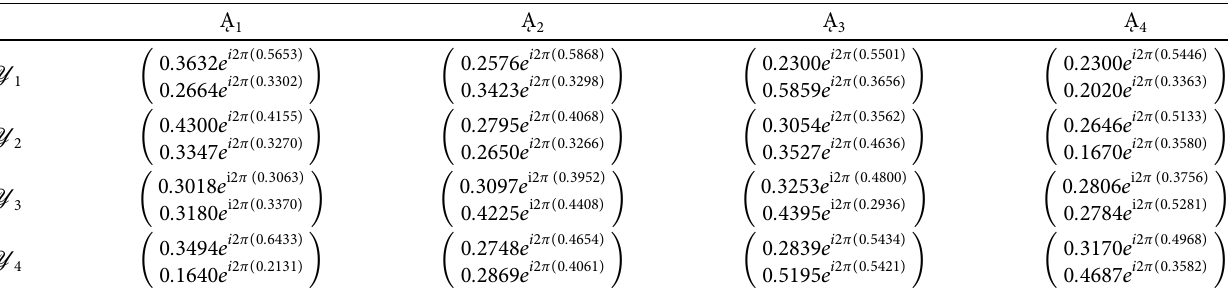
Table 4: Collective DM matrix using the CPFMSM